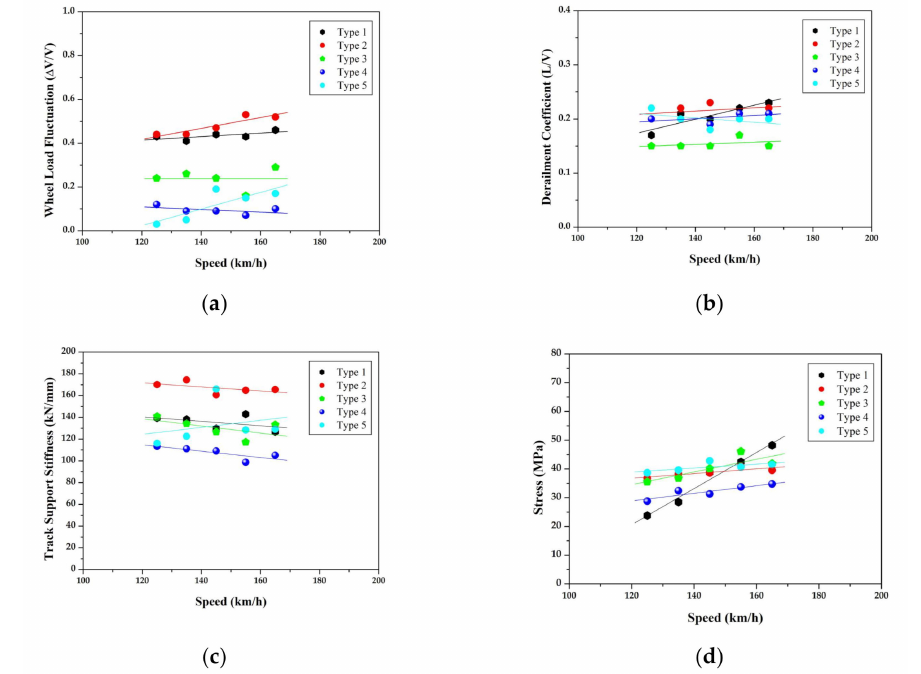
Figure 8. Dynamic stability evaluation result comparison: ( a ) wheel load fluctuation, ( b ) derailment coe ffi cient, ( c ) track support sti ff ness, and ( d ) rail stress.